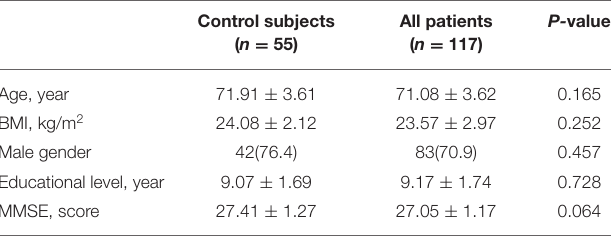
TABLE 2 | Baseline and follow-up data of control subjects and patients. Control subjects ( n = 55)